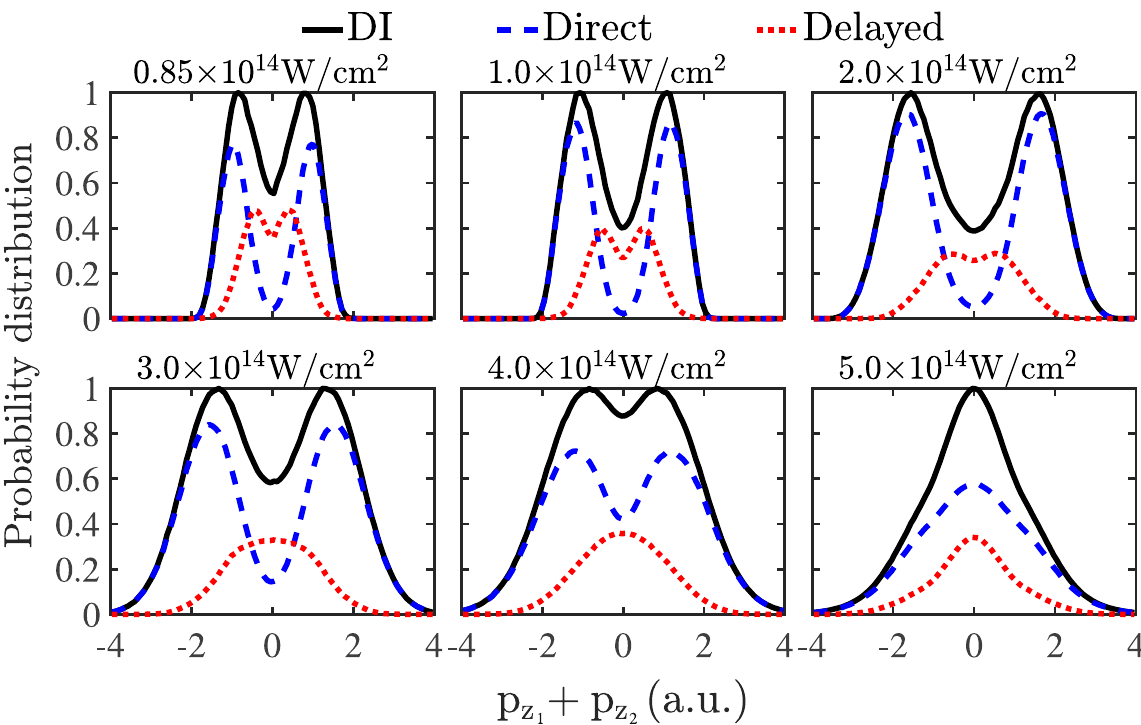
Figure 3. Probability distribution of the sum of the two electron momentum components parallel to the polarization of the laser field (black solid lines) for laser field intensities from 0.85 × 10 14 W/cm 2 to 5 × 10 14 W/ cm 2 . For each intensity, the probability distribution of the sum of the momenta of the delayed pathway (red dotted lines) and of the direct pathway (blue dashed lines) are also plotted. The focal volume effect is not accounted for. Each probability distribution is divided by its maximum